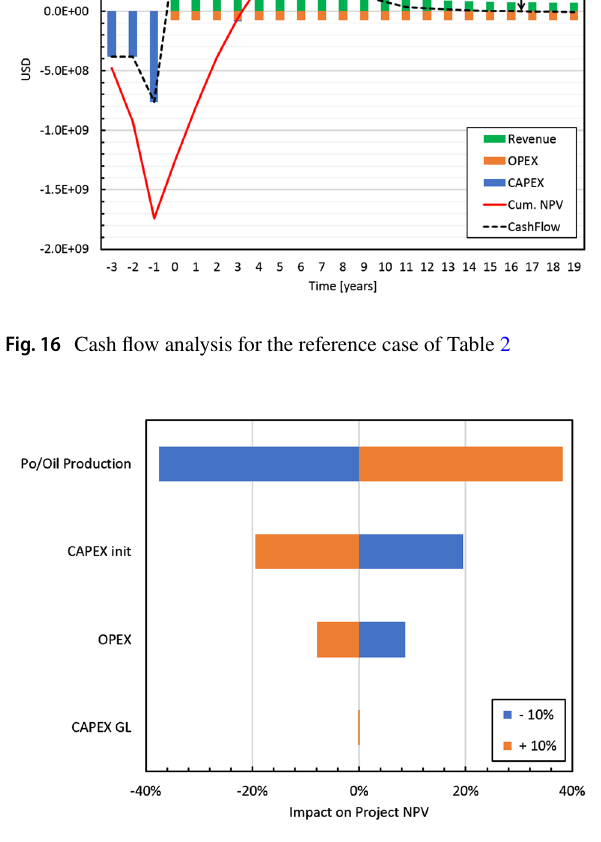
Fig. 15 Yearly OPEX as function of liquid capacity and gas lift injec- tion capacity